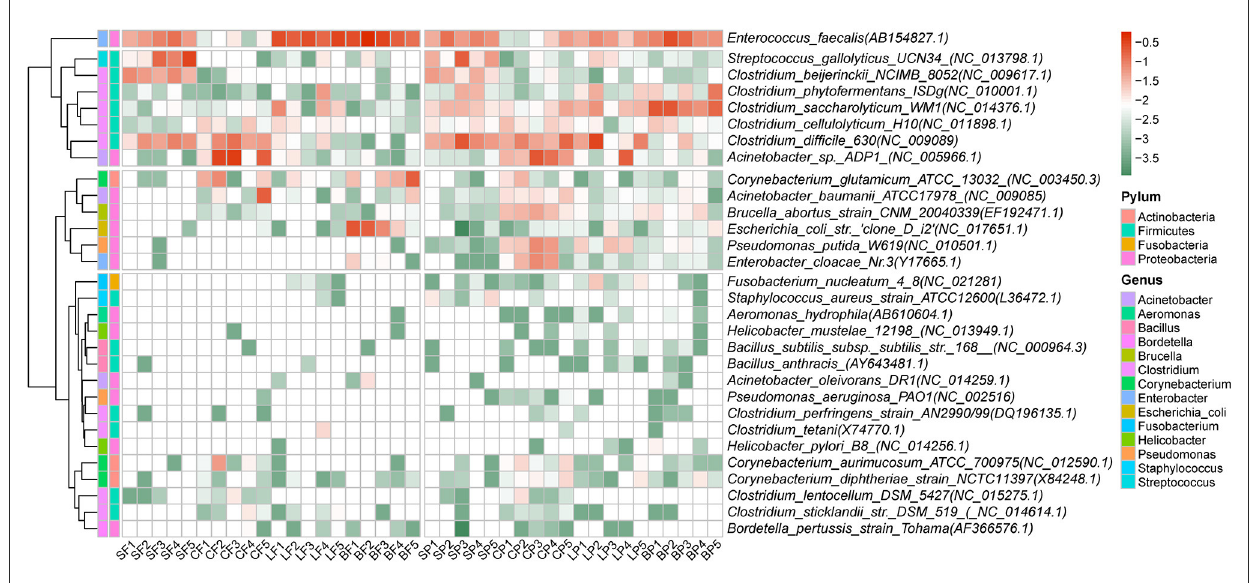
FIGURE3 Relative abundance of dominant 30 human pathogenic bacteria in fecal and PM2.5 samples by animal